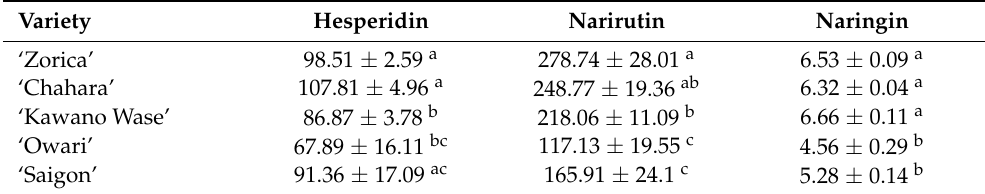
Table 4. Flavonoid content in different varieties of mandarin juice from Neretva valley (Croatia). Results are expressed as mg of compound per L (mg/L) of mandarin juice.